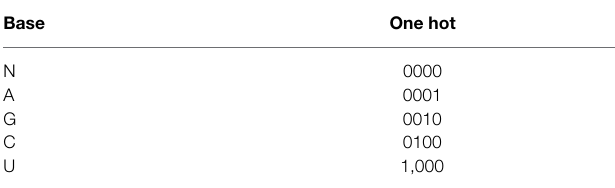
TABLE 3 | Codes corresponding to bases.